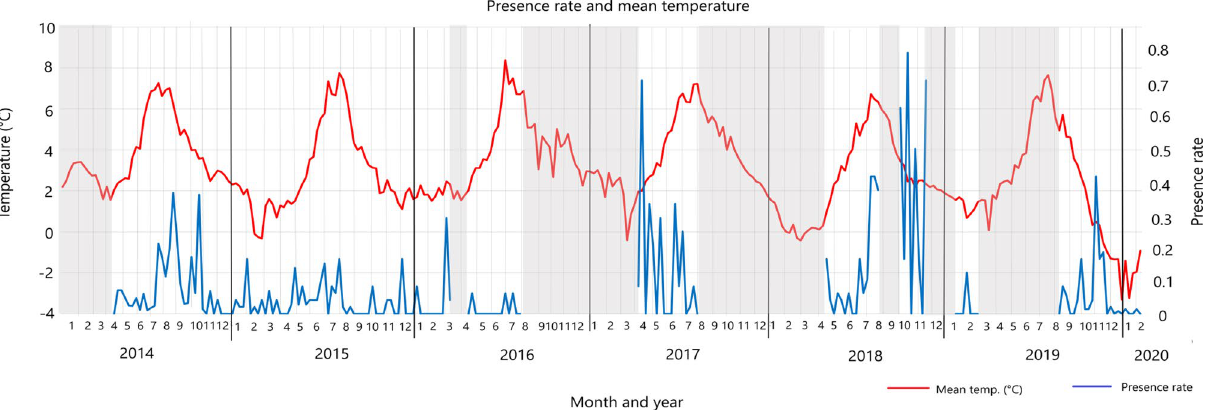
Figure 5. Weekly fin whale presence rate (in blue) and mean sea water temperature (in red). Light grey strips represent periods with no data.